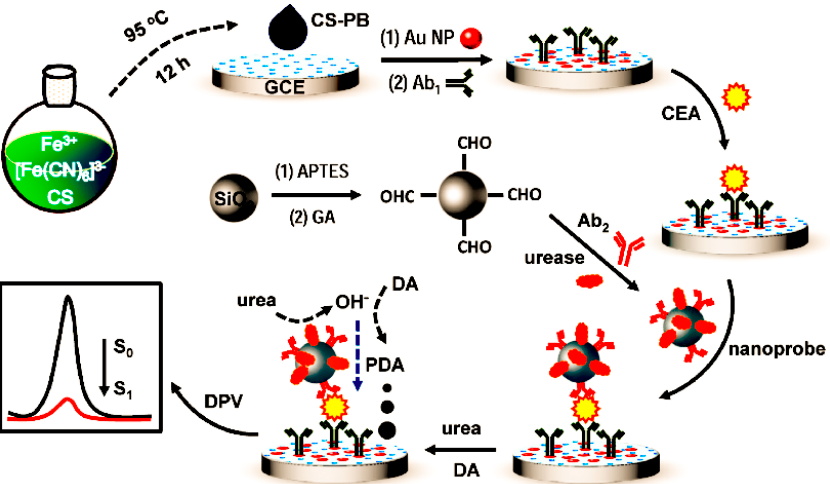
Figure 7. Schematic illustration of the preparation process of the CS–PB–based immunosensor and its electrochemical signal transduction principle [87]. Copyright (2022) Elsevier.